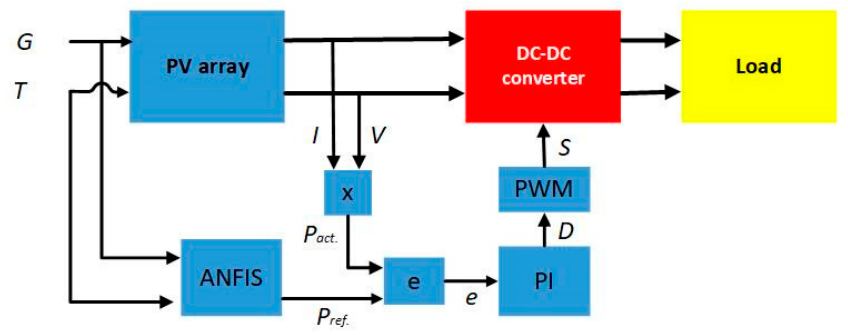
Figure 1. The diagram of photovoltaic (PV) system using an adaptive neuro-fuzzy inference system- maximum power point tracker (ANFIS-MPPT).